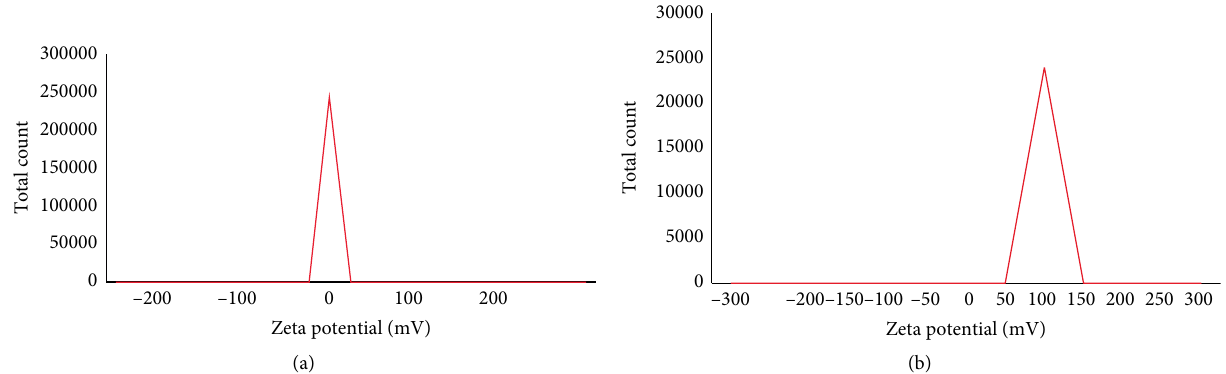
Figure 4: (a) Zeta potential measurement of nanogels in distilled water. (b) Zeta potential measurement of nanogels at pH 6.8.